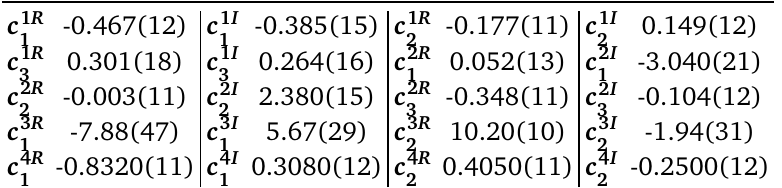
Table 3: Parameters of the nucleon form factor from our fit using the model describing pp production from Ref. [ 94 ]